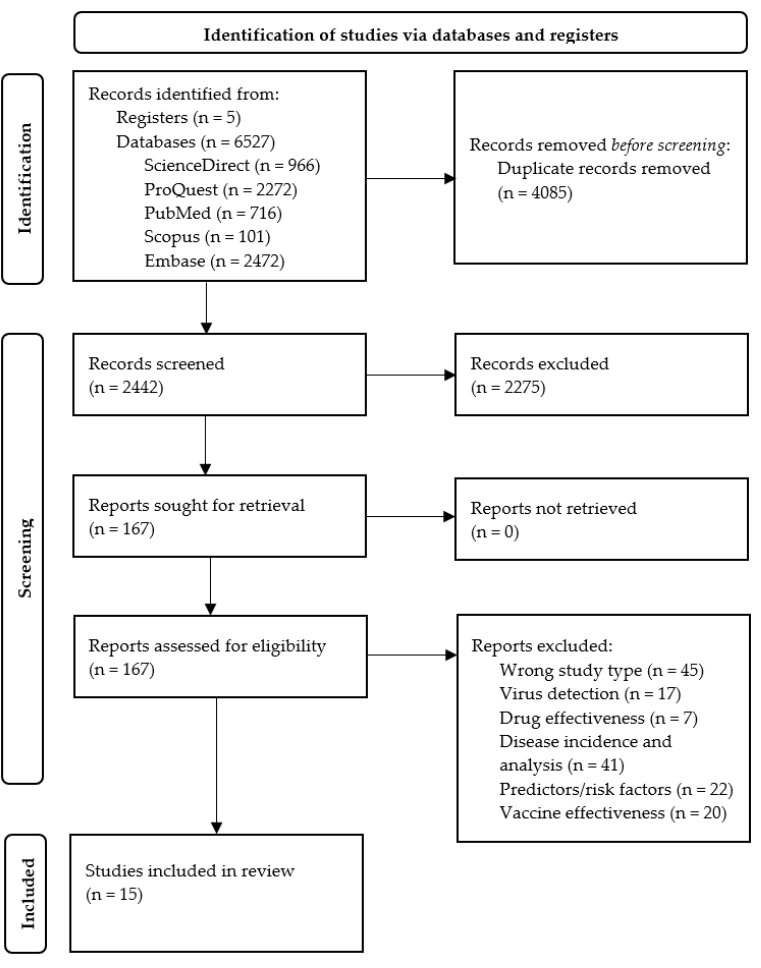
Figure 1. PRISMA 2020 flow diagram.